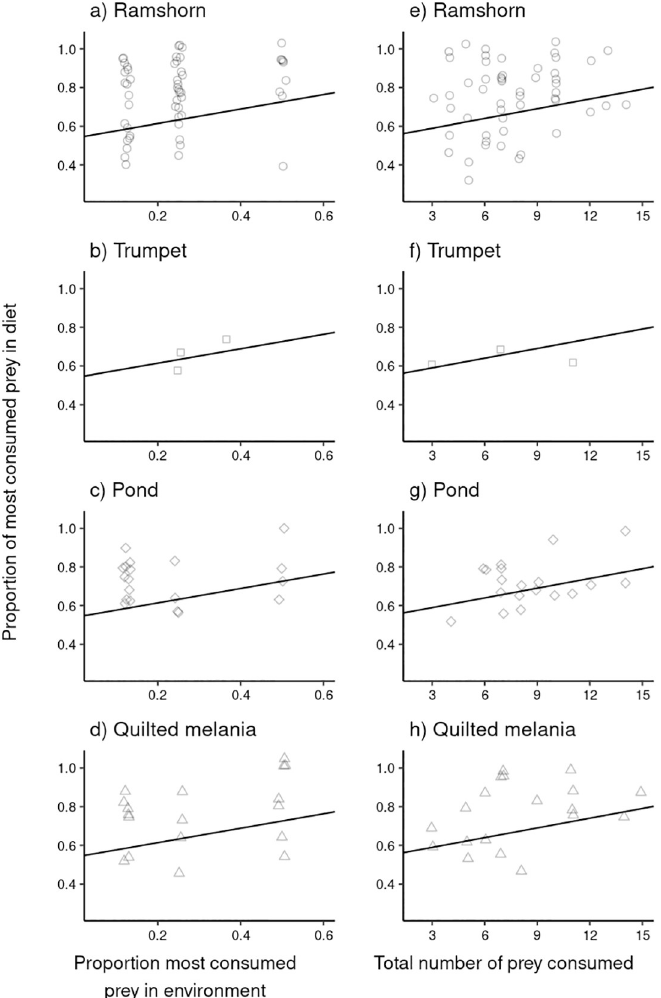
Fig 5. Individual preference of A. helena predators within the population measured in all feeding treatments. The left column (a-d) shows the relative abundance of the most consumed prey plotted against the abundance of the same type of prey in the environment. The solid black line shows the fitted model. Note that the fitted model is the same in all four subplots. The right column (e-h) presents the relative abundance of most consumed type of prey plotted against the total numbers of prey eaten. Again, the black solid line indicates the fitted model. In all graphs, each point corresponds to an individual A. helena predator. Individual data points are slightly jittered horizontally.